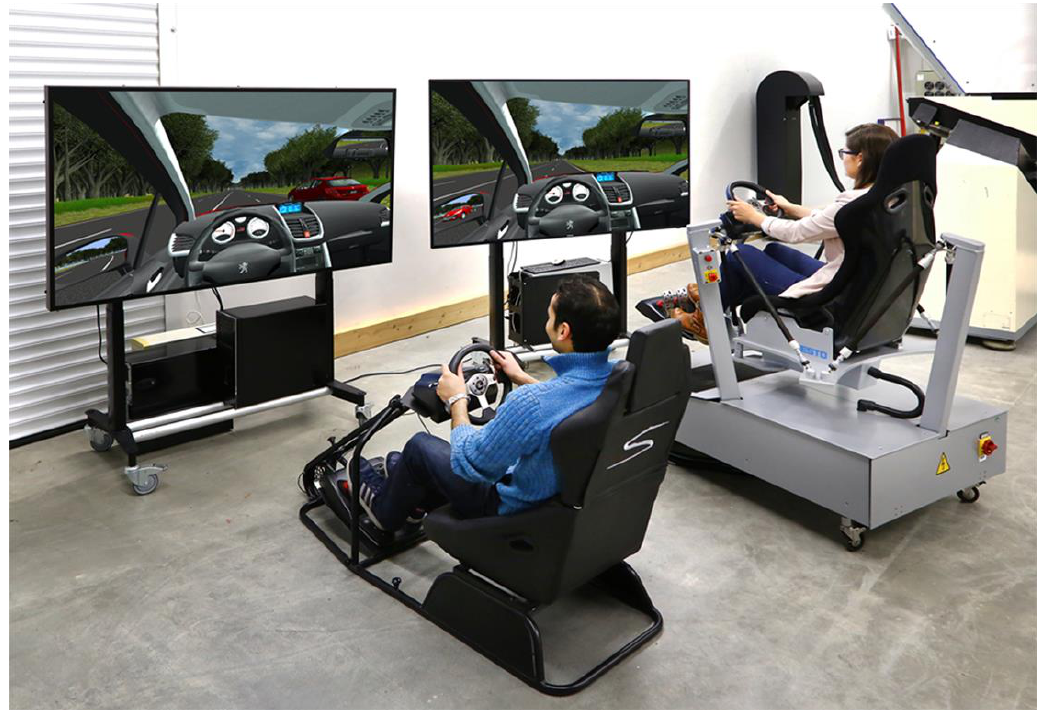
Figure 18. Established platform of networked driving simulation for the second application scenario.